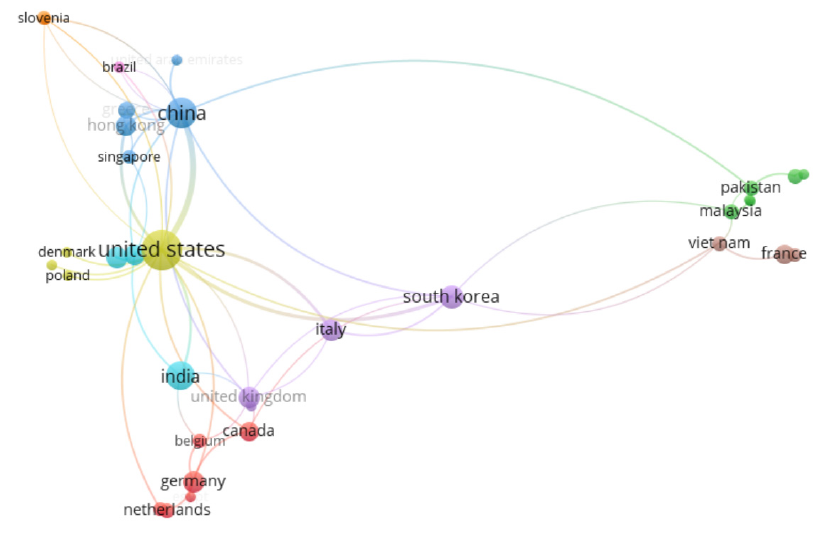
Figure 3. Network visualization of the co-authorship–countries relation for Dataset 1.